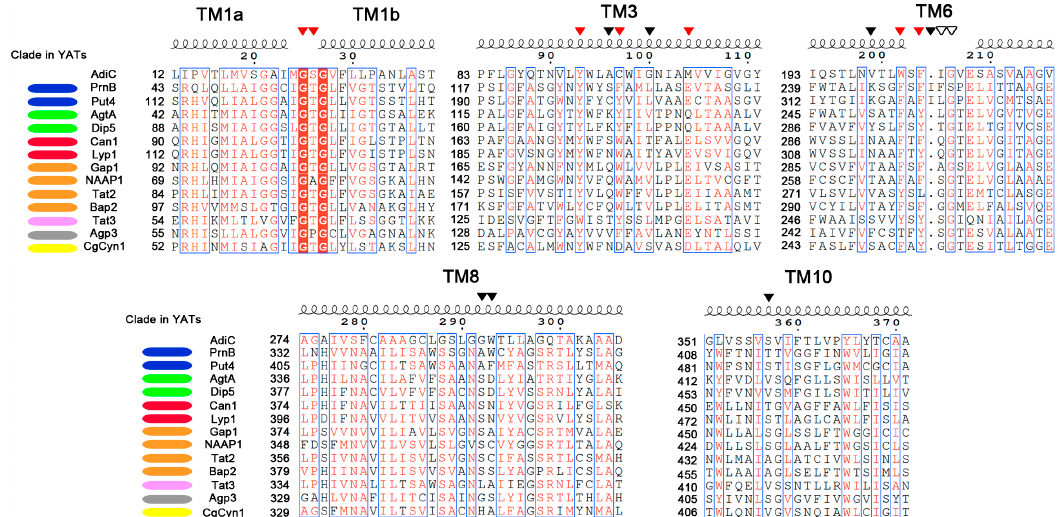
Figure 1. The important residues for substrate binding and determination of the specificity in the YAT family. A multiple alignment of the TMs1, 3, 6, 8 and 10 sequences from selected YAT members—for most of which structure-function studies have been performed. Residues in red font are highly conserved, while residues in red filled columns are absolutely conserved in the sequences of the selected YATs. Blue frames define residues that are conserved at least 70% of the sequences. Red triangles indicate the positions of residues that are highly conserved in YATs and are predicted to interact with the backbone of the amino acid substrates. Black triangles indicate specificity-determining residues that are poorly conserved in YATs and predicted to interact with the side chain of the amino acid substrates. Empty triangles indicate residues that indirectly affect the specificity of YATs. Color-coding next to the names of YATs shows which clade of the phylogenetic tree of Figure 2 the transporters belong to. The annotation of the alignment was done with ESPript 3.0 [45].